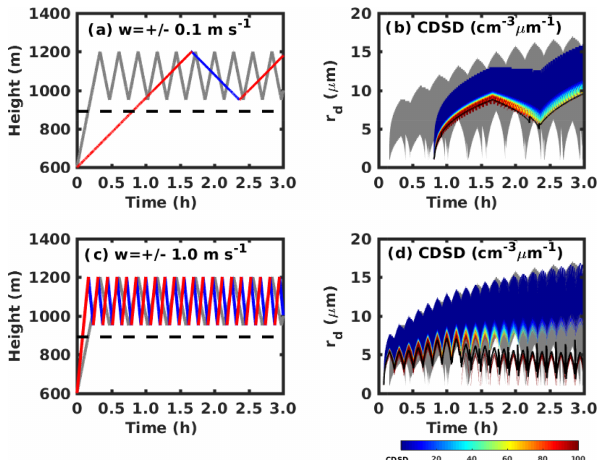
Figure 5. (a) The height of cloud parcel changes with time for the low velocity case of ± 0 . 1ms − 1 . (b) Cloud droplet size distribu- tion changes with time for the low velocity case. (c) The height of the cloud parcel changes with time for the velocity of ± 1 . 0ms − 1 . (d) Cloud droplet size distribution changes with time for the high velocity case. Red and blue lines in (a) and (c) represent ascending and descending parcels, and gray lines represent the control case with velocity of ± 0 . 5ms − 1 . The gray regions in (b) and (d) are the range of cloud droplet spectrum for the control case.